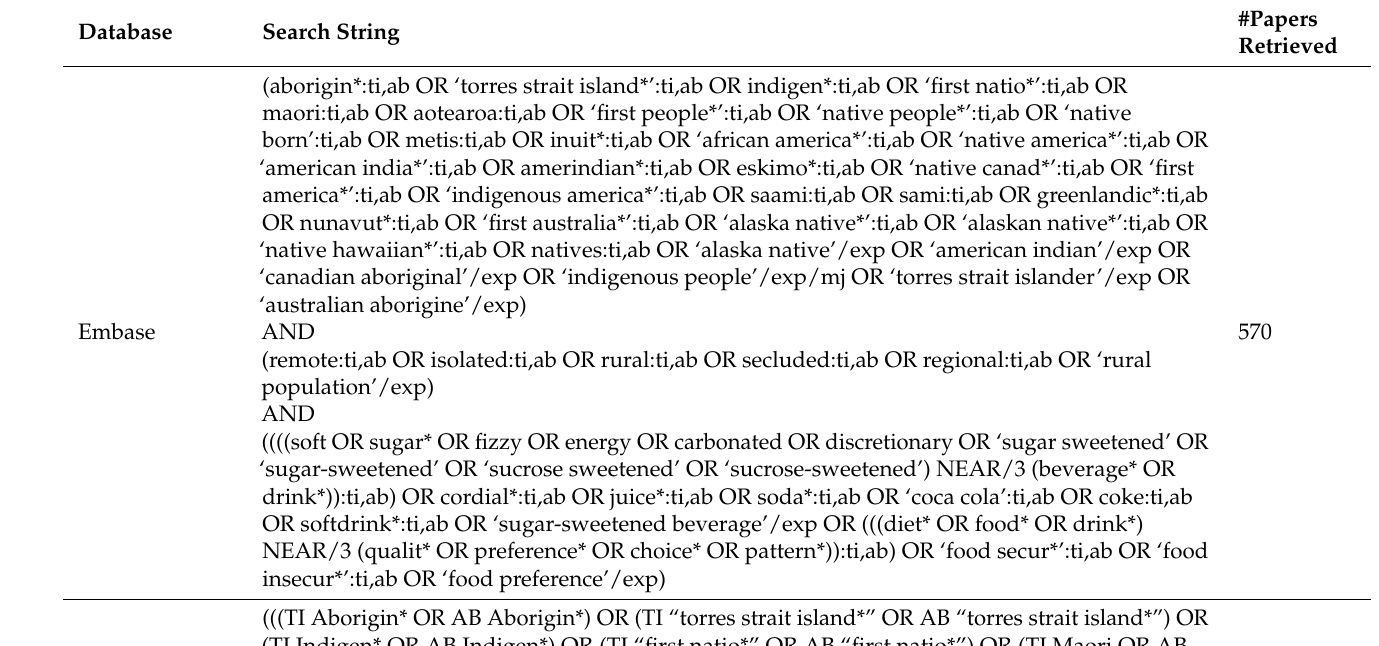
Table 1. Search strings for all databases used in the